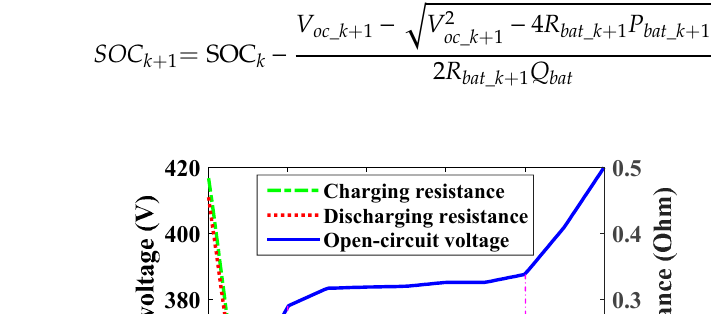
8 of 23 Figure 7. The simplified internal resistance battery model.